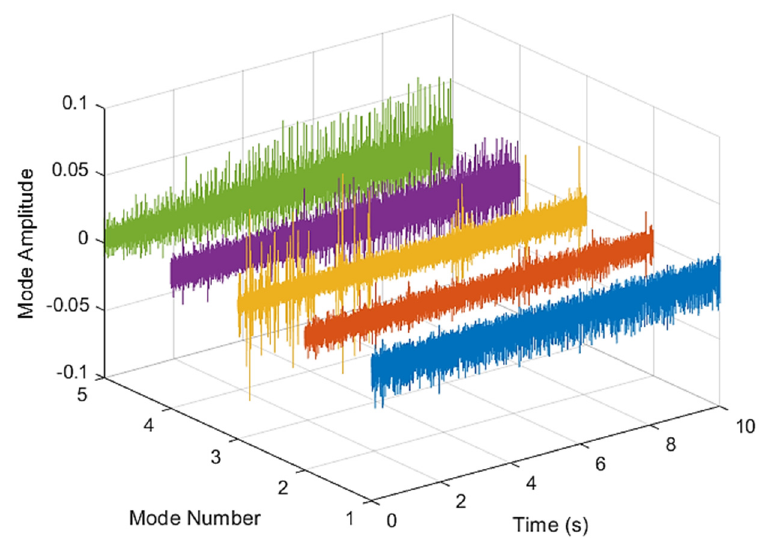
Figure 7. VMD analysis from an outer race fault bearing under increasing rotational speed condition in time domain.